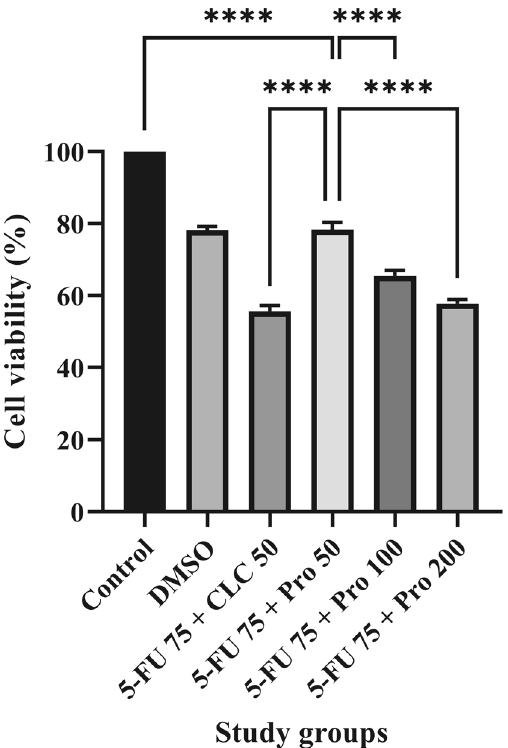
Figure 2. Effect of different doses of propolis on the viability of rat myocardium (H9C2(2–1)) cell line. All values are expressed in mean ± SD. **** indicate p <